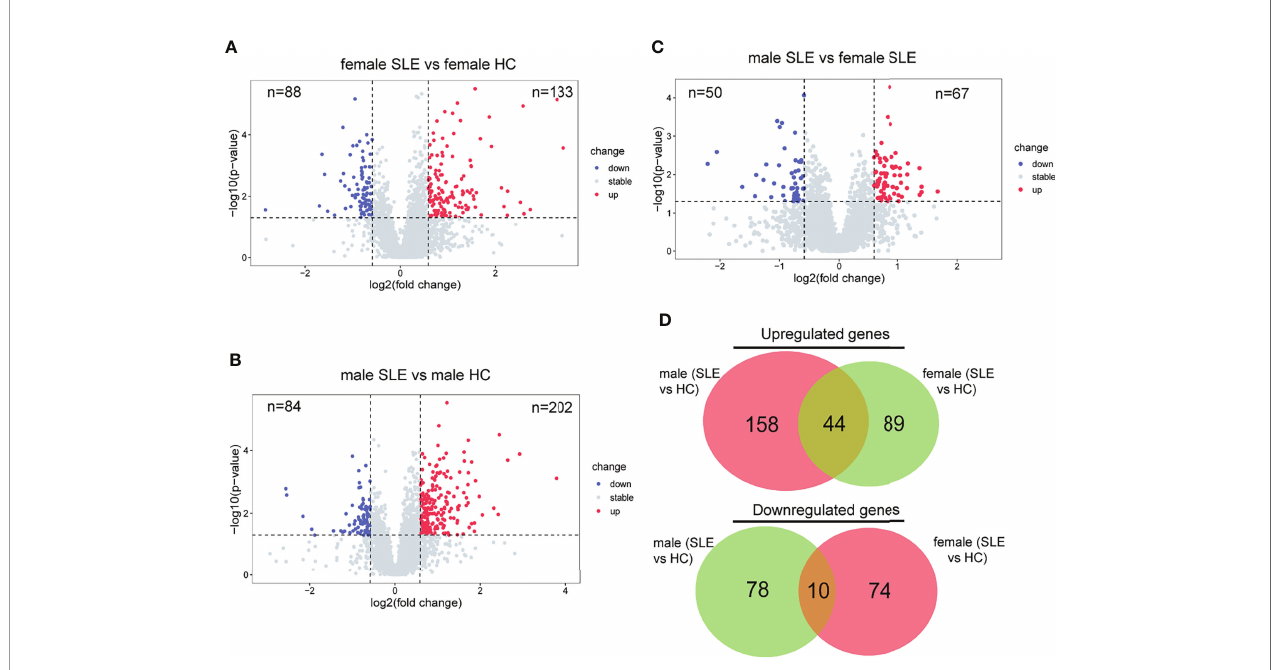
FIGURE 3 | Proteomic heterogeneity among SLE and healthy control with different gender. (A – C) Volcano plot showing DEPs between female SLE versus female HC, male SLE versus male HC, and male SLE versus female SLE. (D) Venn diagram showing number of proteins with signi fi cant upregulation or downregulation comparing SLE with healthy